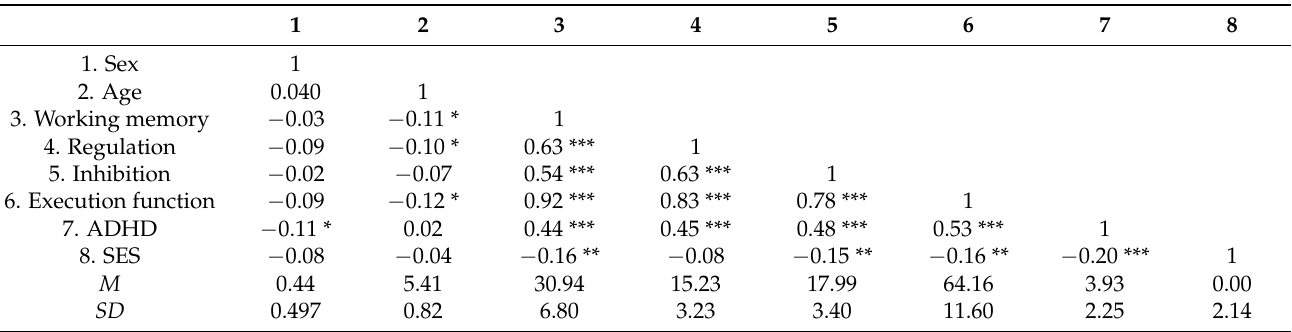
Table 2. The descriptive statistics results and correlation analysis between variables.